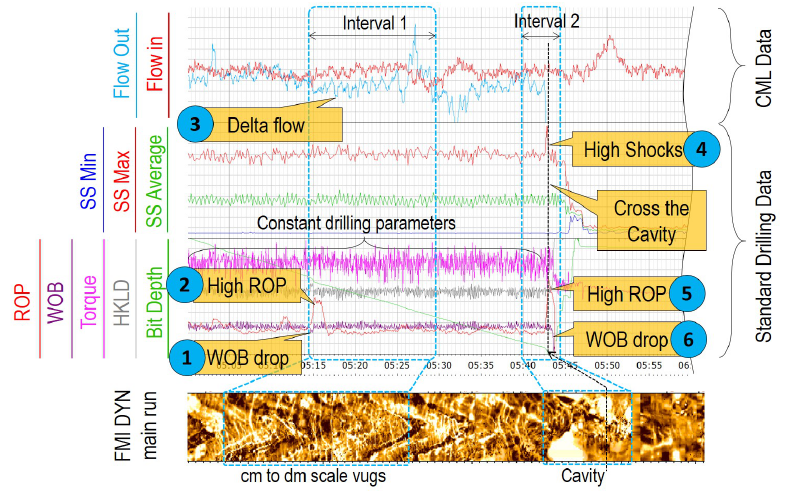
Figure 9. Drilling through the intervals of vugs and cave. Standard and flow data (Well